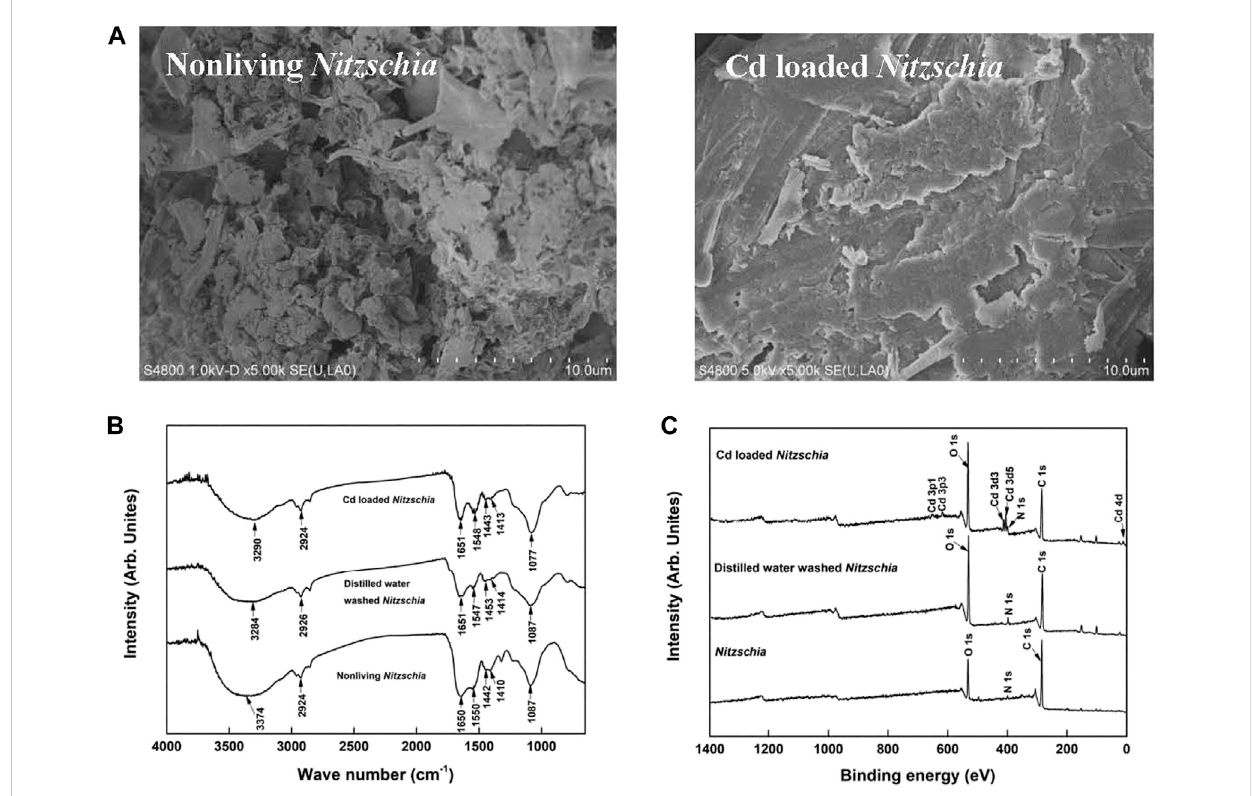
FIGURE 6 Characteristics of non-living, distilled water-washed, and Cd-loaded Nitzschia biomass. (A) SEM images, (B) FTIR spectra, and (C) XPS